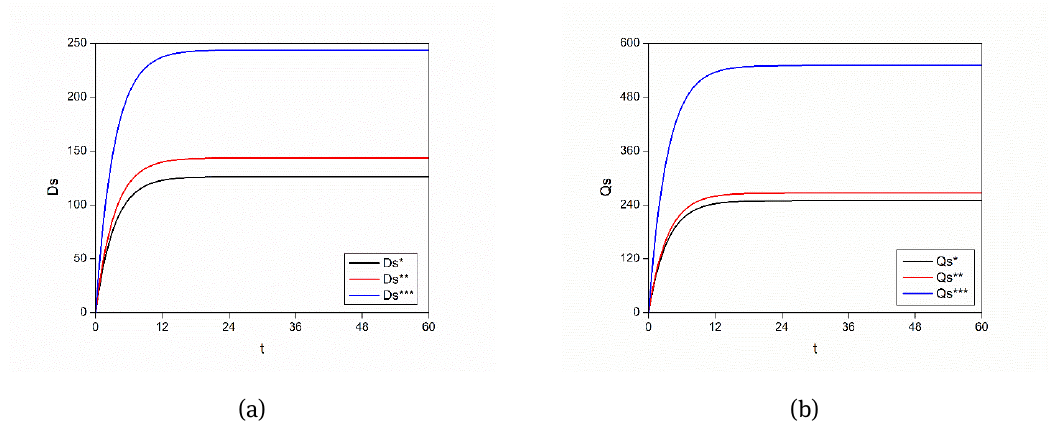
Figure 1: Change trend of supplier’s product green degree and reputation.